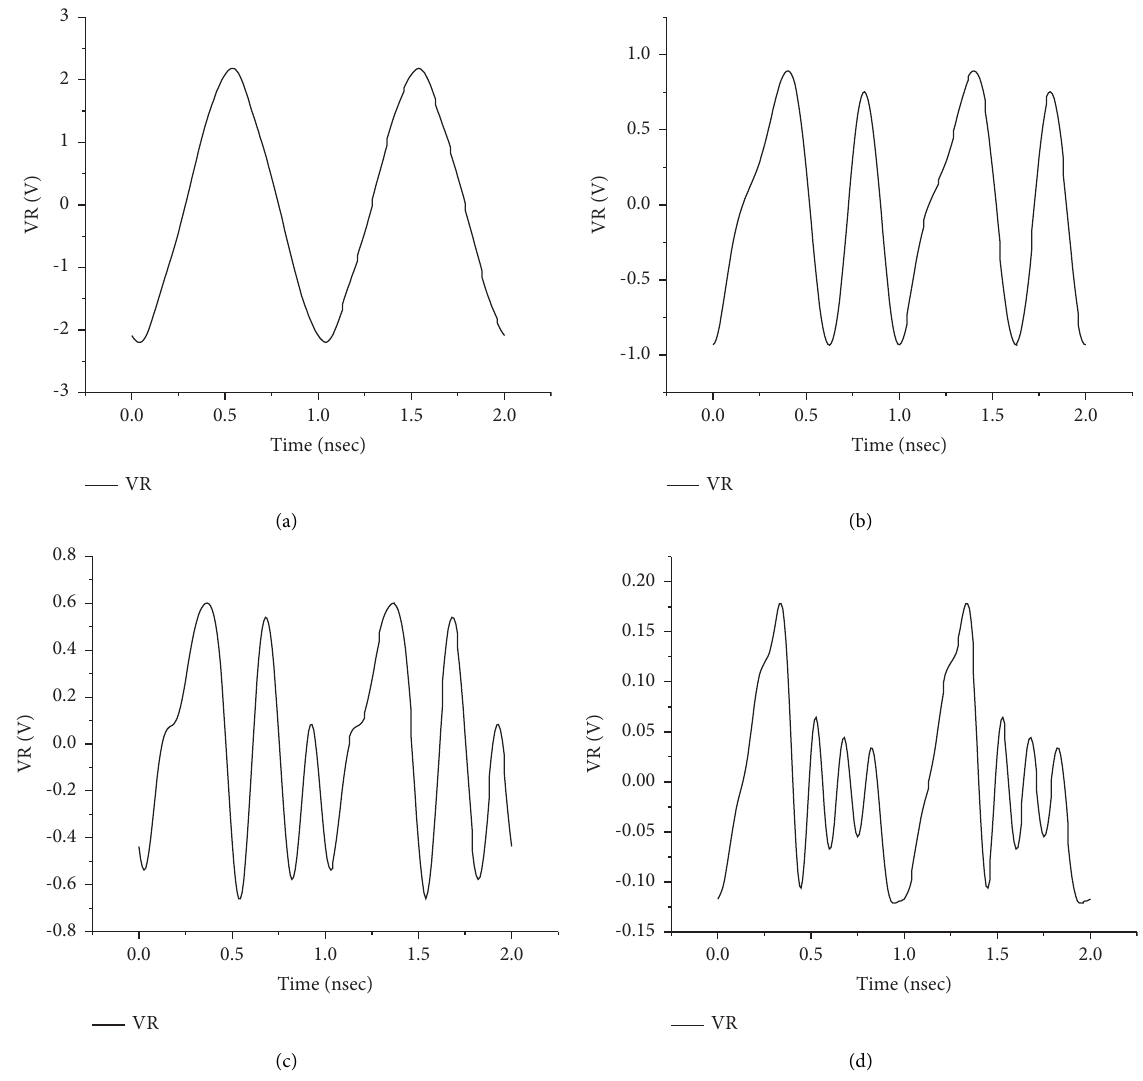
Figure 7: Diagram of period doubling: (a) single period, (b) period doubling, (c) period tripling, and (d) period